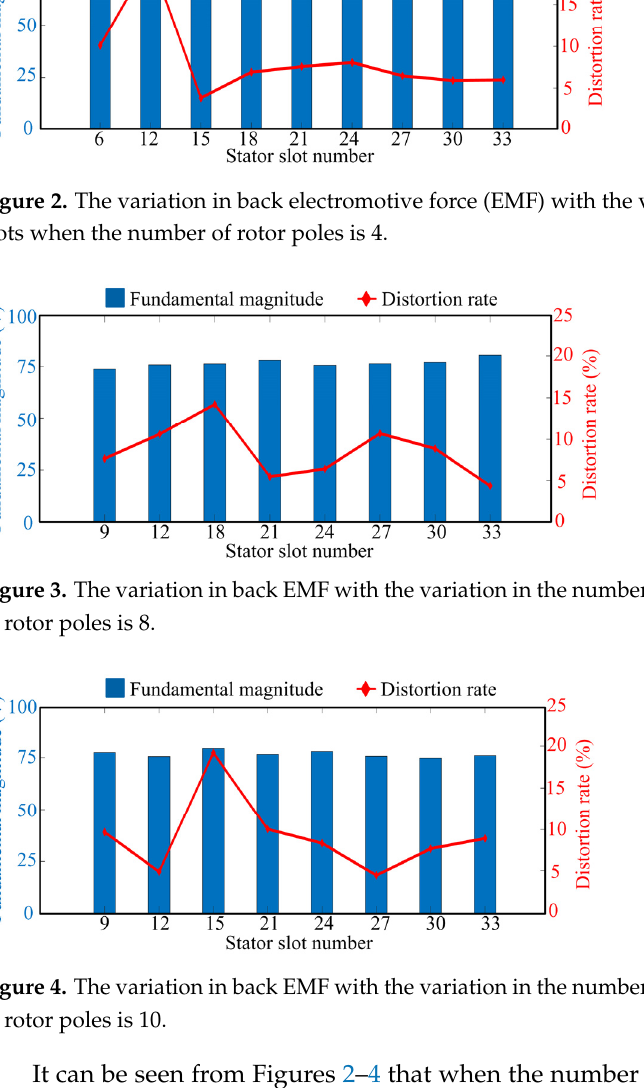
6 of 15 Figure 1. Structure diagram of a 4-pole and 24-slot surface-mounted permanent magnet (SPM) machine. 3. Effect of Stator Slot and Rotor Pole Combination The machine design schemes corresponding to different stator slot and rotor pole combinations are given in the Section 2. On this basis, the finite element (FE) simulation models of SPM machines are established by Ansys Maxwell. Correspondingly, back EMF, cogging torque, electromagnetic torque, and loss and efficiency are calculated and compared under different stator slot and rotor pole combinations in this section. The corresponding calculation results will provide guidance in the selection of a stator slot and rotor pole combination.